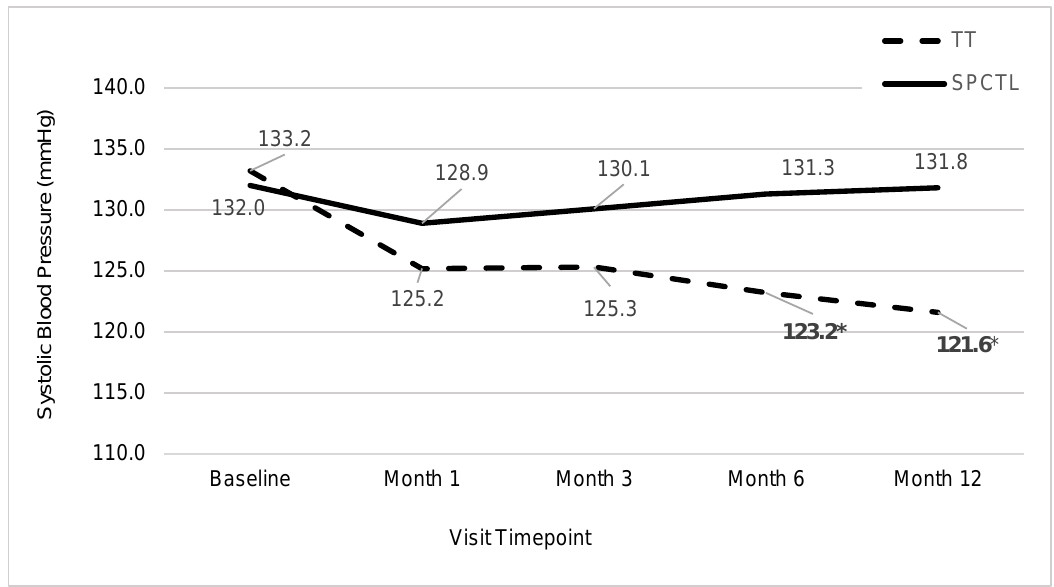
Figure 3. Average Systolic Blood Pressure by Group and Visit.